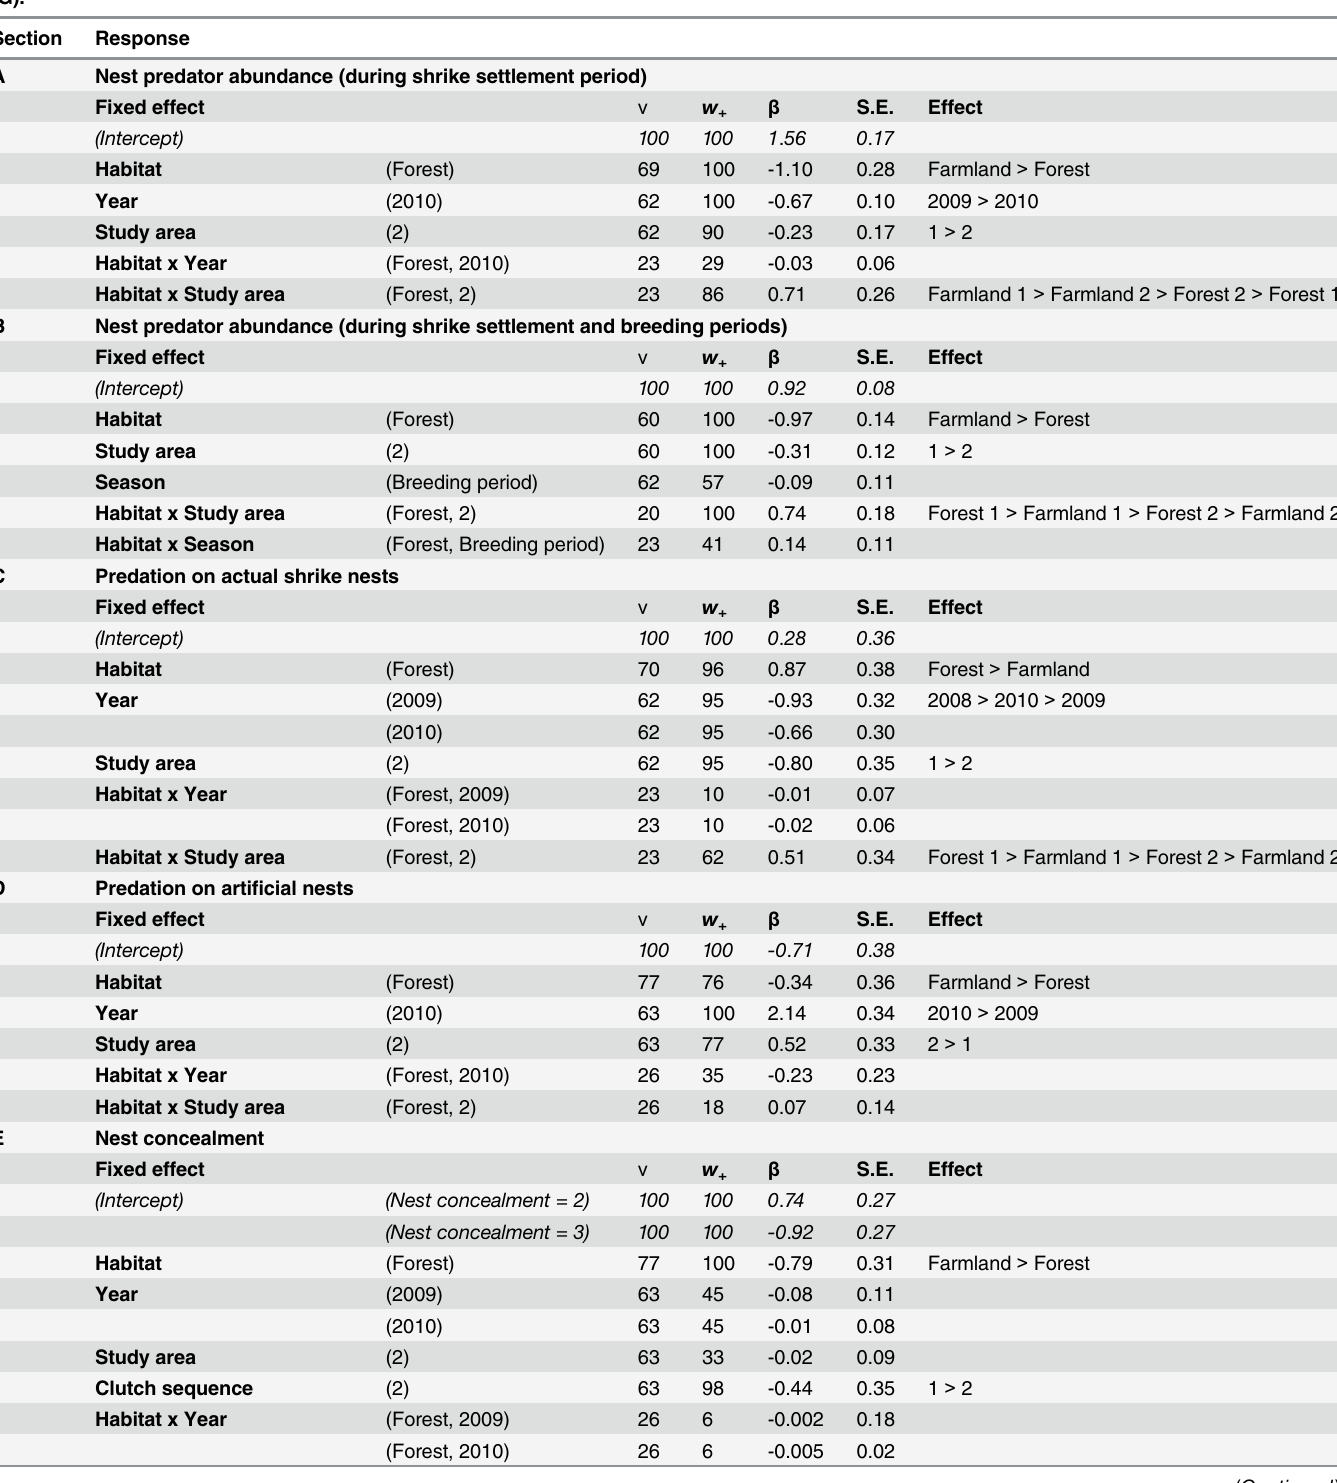
Table 3. Results of the AIC c -weighted GLMM (sections A-F) and GLM (section G) model selection procedures for the analyses of nest predator abundance (all corvid species together; A, B), nest predation (C, D and F), nest concealment (E) and the level of parental caution during nest visits